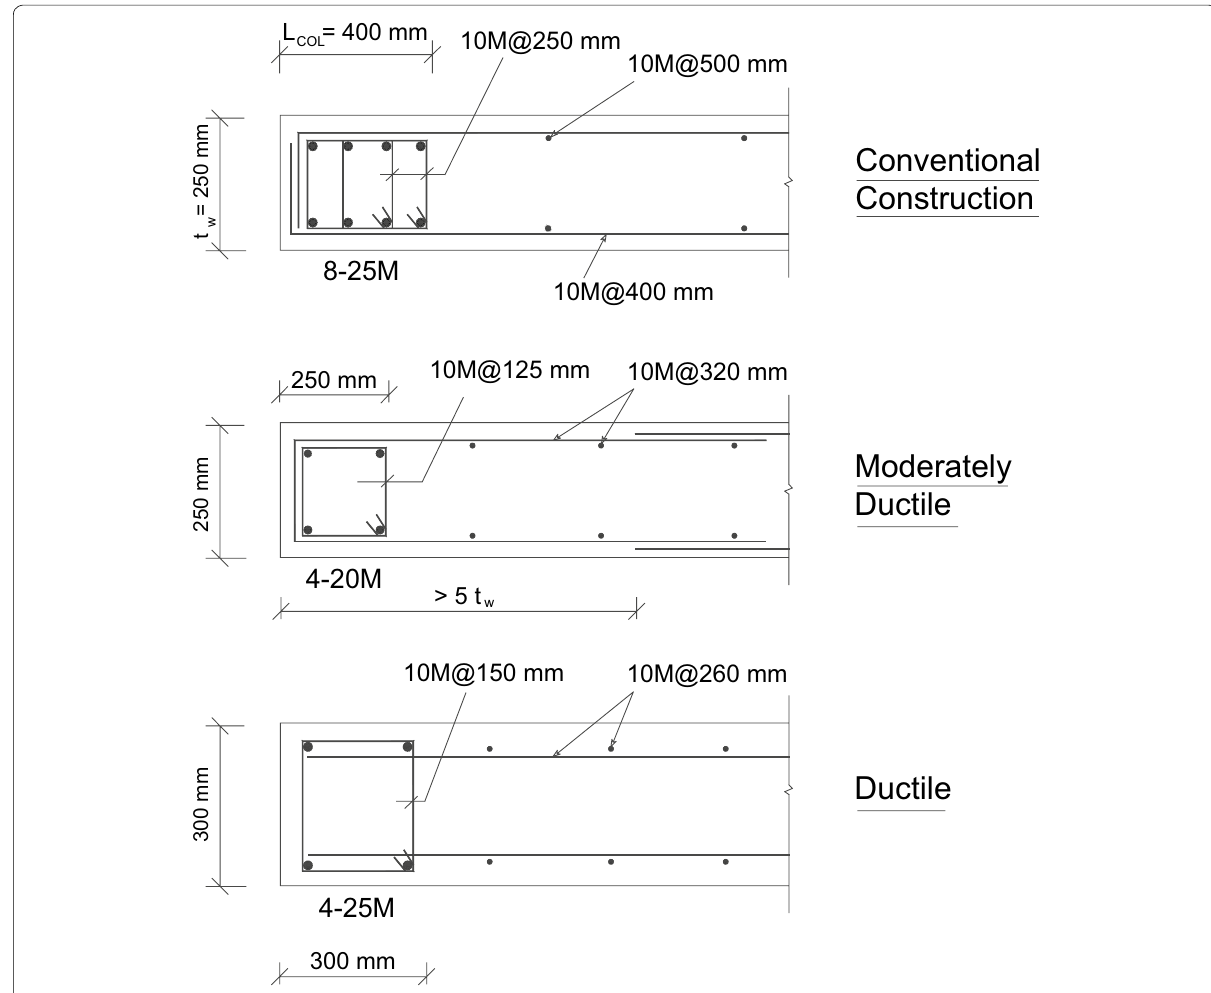
Fig. 5 Reinforcement details of the 10‑storey shear walls in